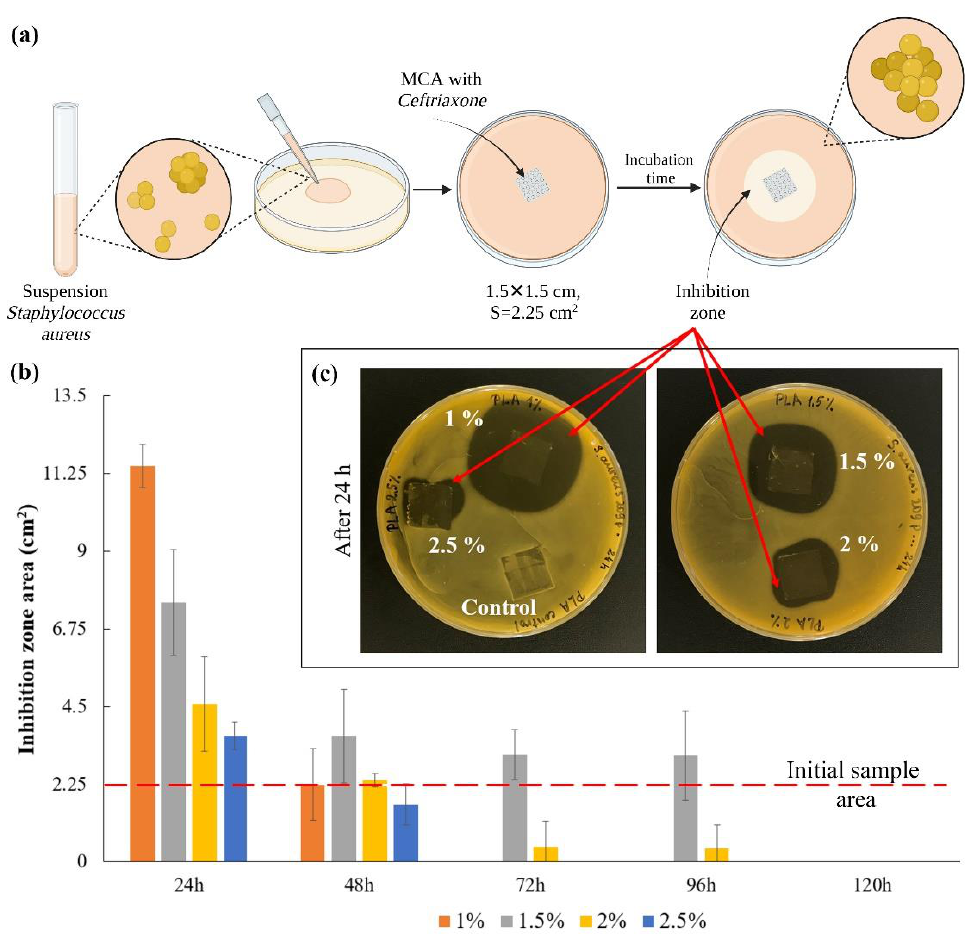
Figure 5. The scheme for assessing the bacterial activity of microchamber arrays containing ceftriaxone ( a ); the inhibition zones area after the first 24 h ( b ); the image of plates with samples after 24 h ( c ).